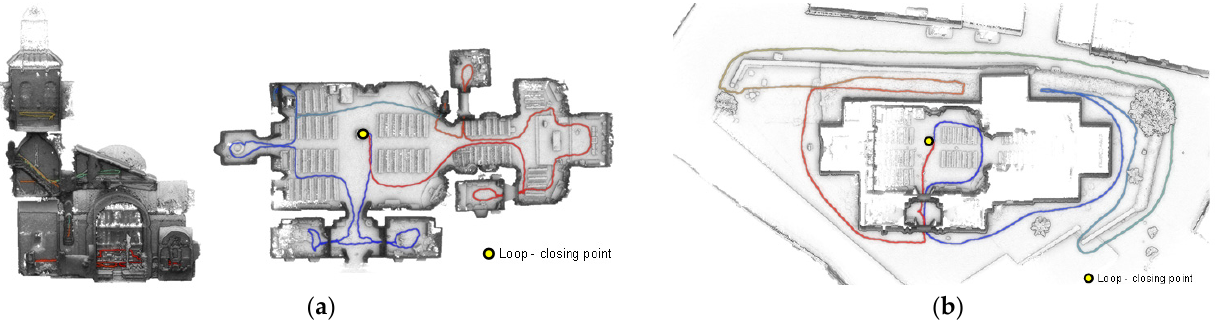
Figure 6. Plant representation of the different rings performed: ( a ) for capturing the indoor envelope of the church and ( b ) for capturing the external envelope. In red, the path followed, on which it is possible to observe the data captured by the GoPro camera, is represented. The overlap between rings in the central nave for the subsequent alignment should be noted.